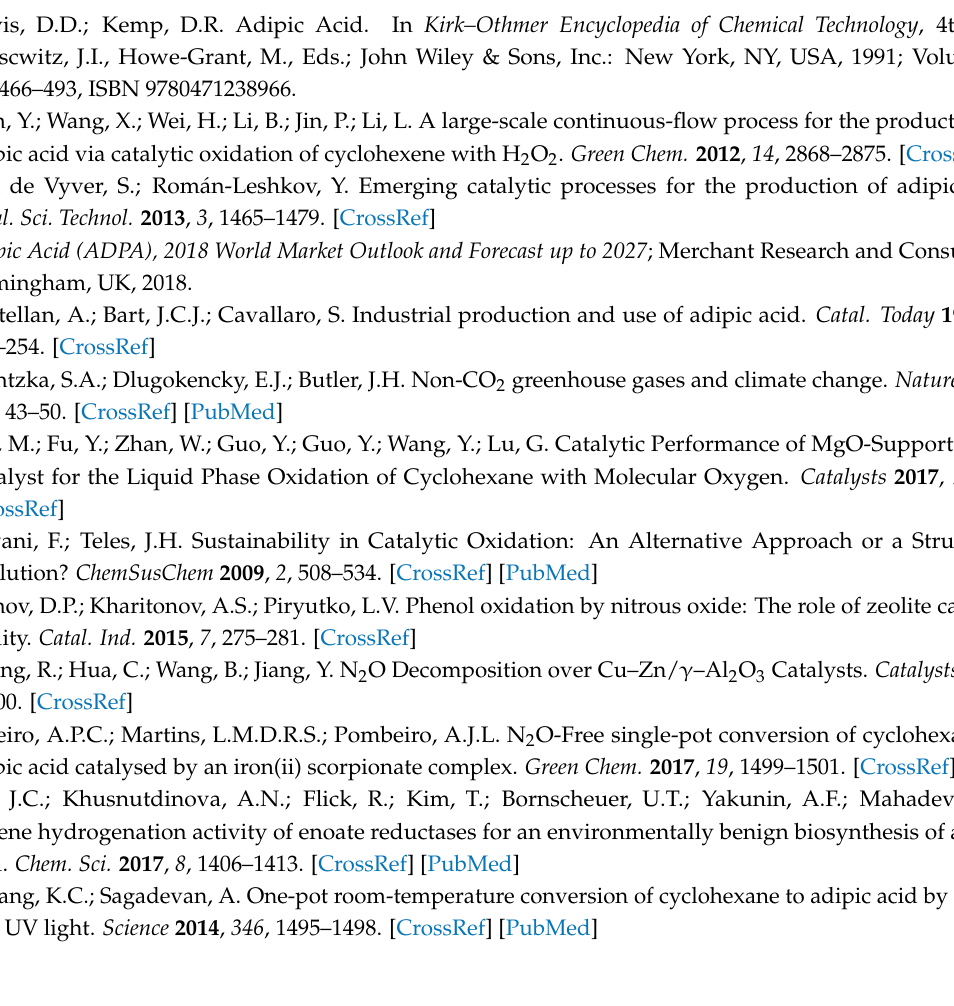
Figure S8. The ESI-MS of products from the catalytic oxidation of cyclohexanol at room temperature, Figure S9. The ESI-MS of white crystalline products generated from cyclohexanol with